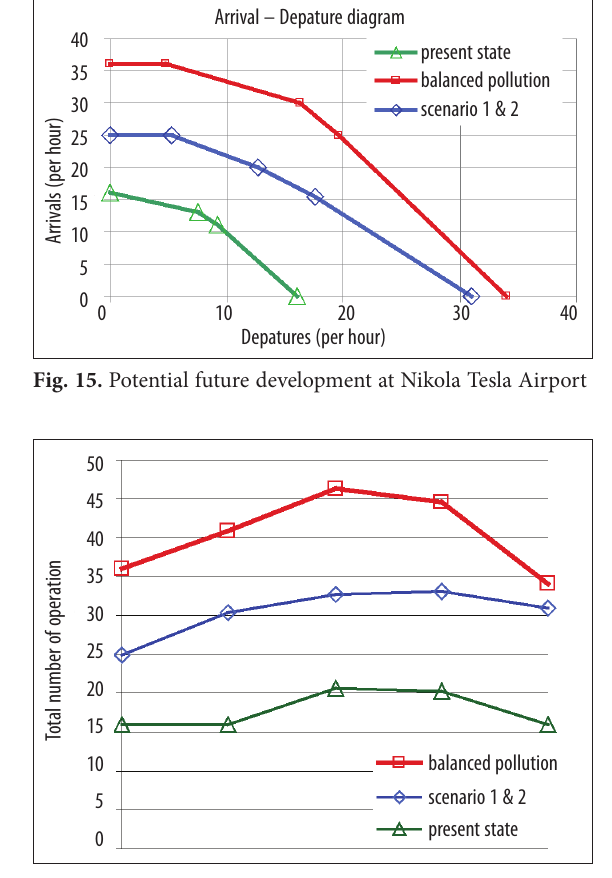
Fig. 16 . The airport capacity of total number of operations for various traffic assignment scenario